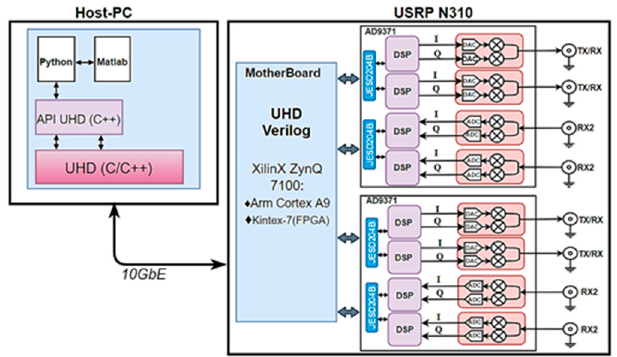
Figure 3. Block diagram of software interface between Host-PC and Universal Software Radio Peripheral (USRP) N310.